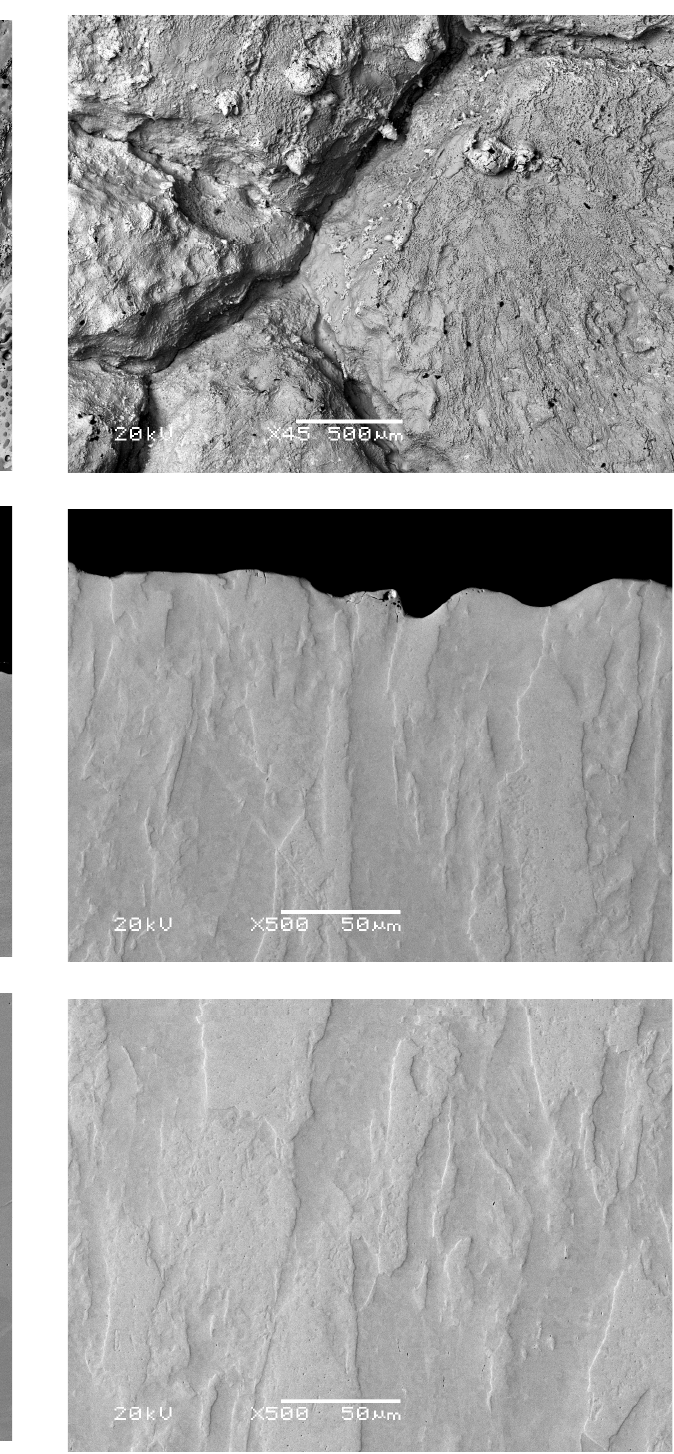
material.FIG. 3. Backscattered electron micrograph for stainless steel alloy 304L. The top picture is a surface picture of an arc region. The middle picture is a cross section of an arced region. The bottom picture is a cross section of the bulk